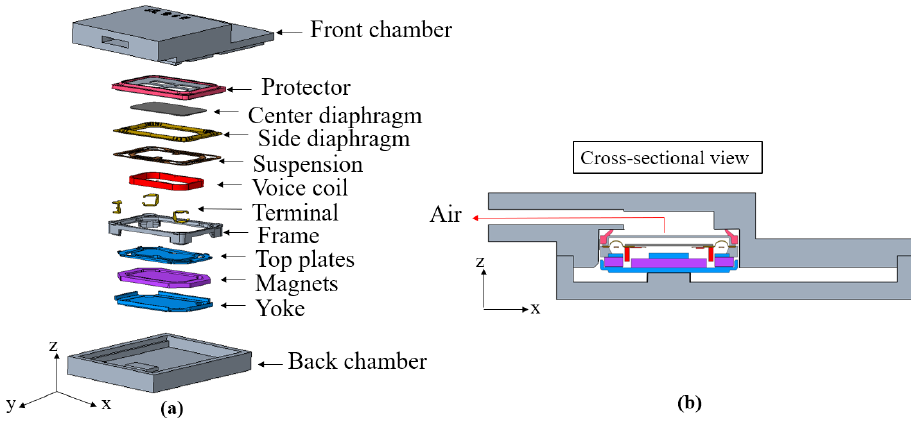
Figure 2. Structure of microspeaker module: ( a ) exploded view; ( b ) cross-sectional view.